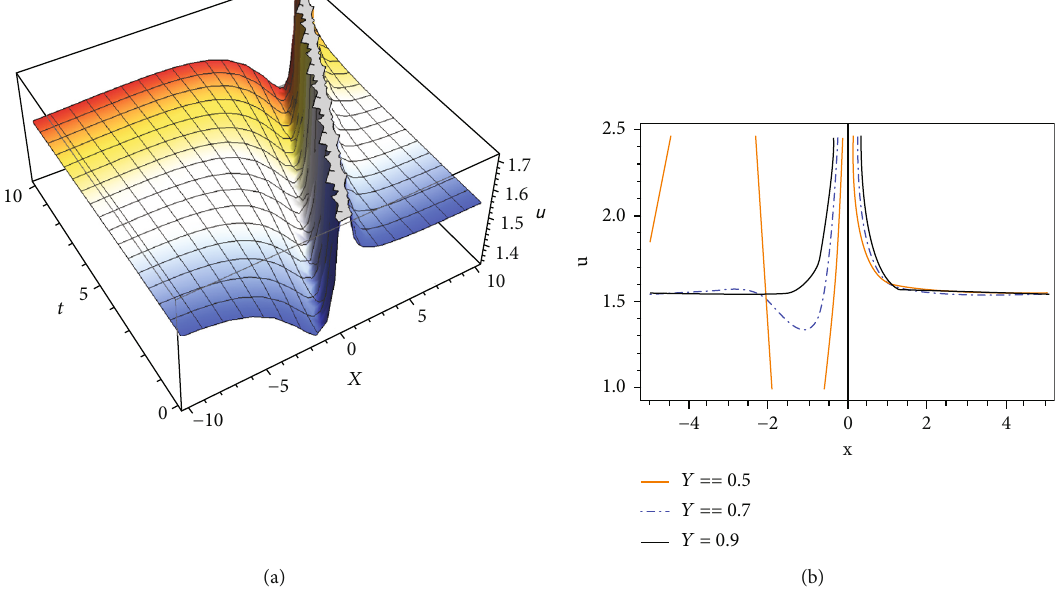
j . (a) The 3D graph of u 3,2